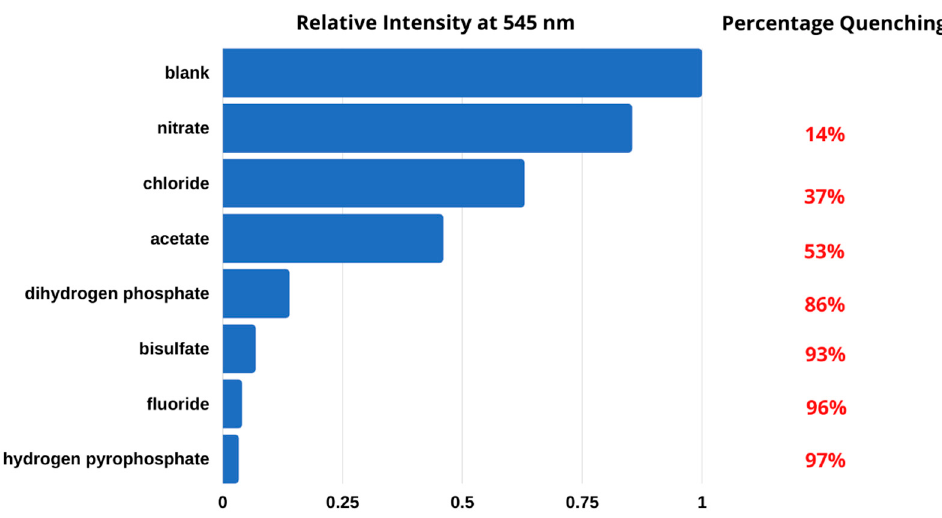
Figure 6. Steady state emission spectra of[ Tb. 1] (OTf) 3 (9.9 µM) in the presence of 1 equivalent of anions. Pictures show [Tb. 1] (OTf) 3 (50 µM) in the presence of 1 equivalent of each anion.